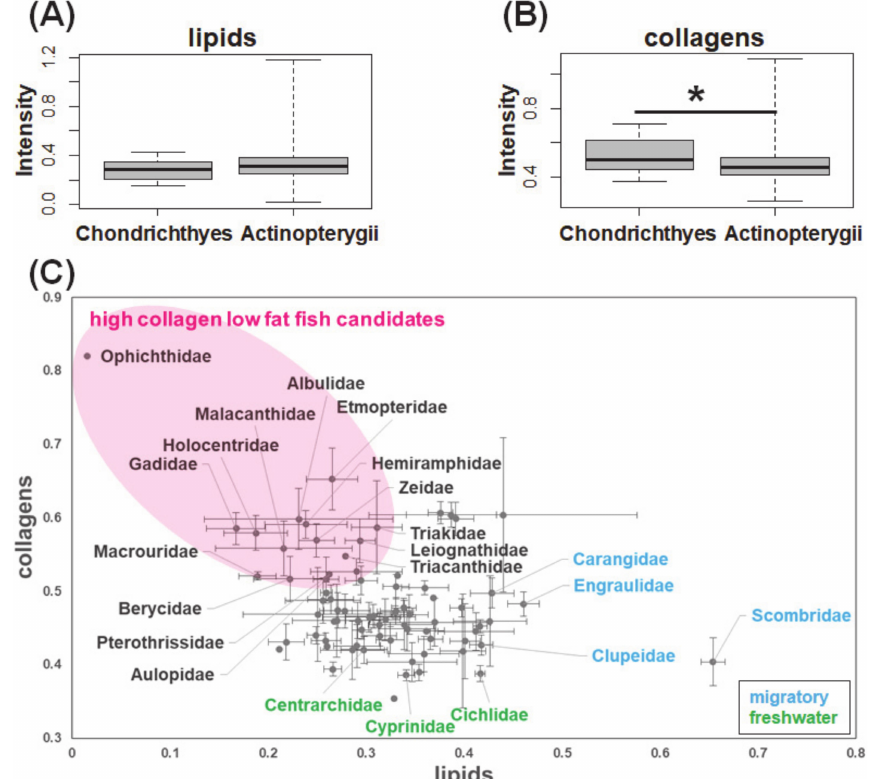
Figure 4. Macromolecular distribution in fish diversity: box plots of ( A ) lipids ( p -value = 0.2156) and ( B ) collagens ( p -value = 0.02159, * indicates a significant di ff erence when p -value < 0.05) according to class, and ( C ) scatter plots according to family (mean ± standard